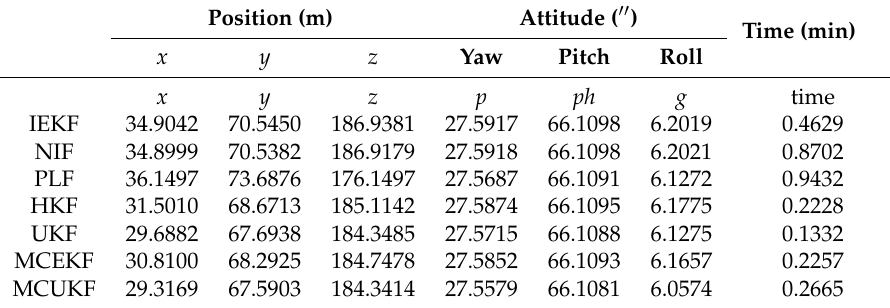
Table 6. RMSE of position, attitude, and time cost of different methods in the presence of large outliers for SINS/CNS deeply integrated